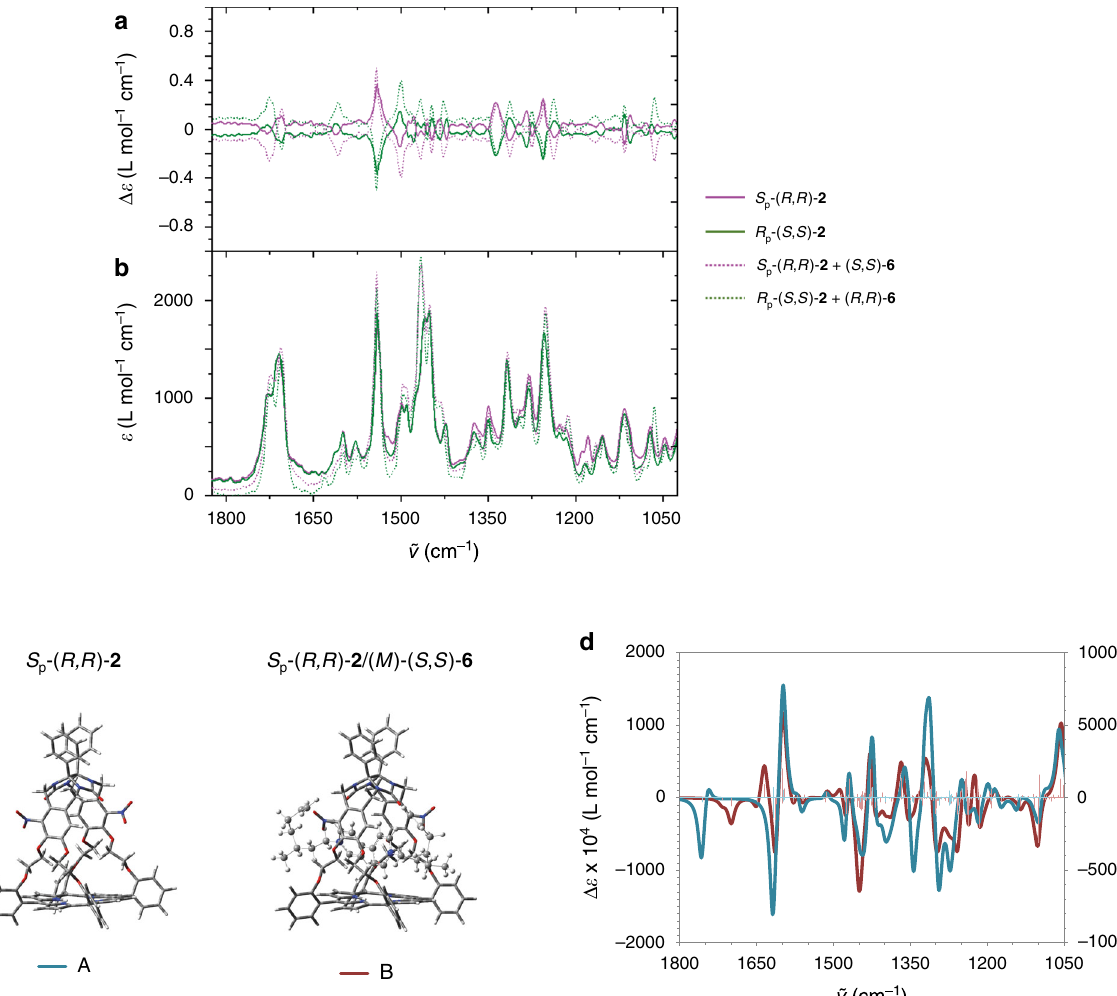
Fig. 6 VCD spectra of chiral hosts and chiral host – guest complexes. a VCD spectra of S p -( R , R )- 2 (purple line) and R p -( S , S )- 2 (green line) and of the complexes between S p -( R , R )- 2 and ( S , S )- 6 (purple dotted line), and R p -( S , S )- 2 and ( R , R )- 6 (green dotted line). b IR spectra of these hosts and host – guest complexes. Solvent CDCl 3 . c Calculated conformation of the host S p -( R , R )- 2 (A) and of the complex S p -( R , R )- 2 /( M )-( S , S )- 6 . d Calculated VCD spectra of the retained conformation A of the host S p -( R , R )- 2 (blue line and blue bars: rotational strengths), and of the conformation B of the complex S p -( R , R )- 2 / ( M )-( S , S )- 6 (red-brown line and red-brown bars: rotational